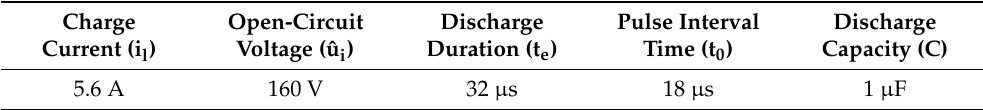
Table 2. Parameters for electro-discharge drilling.